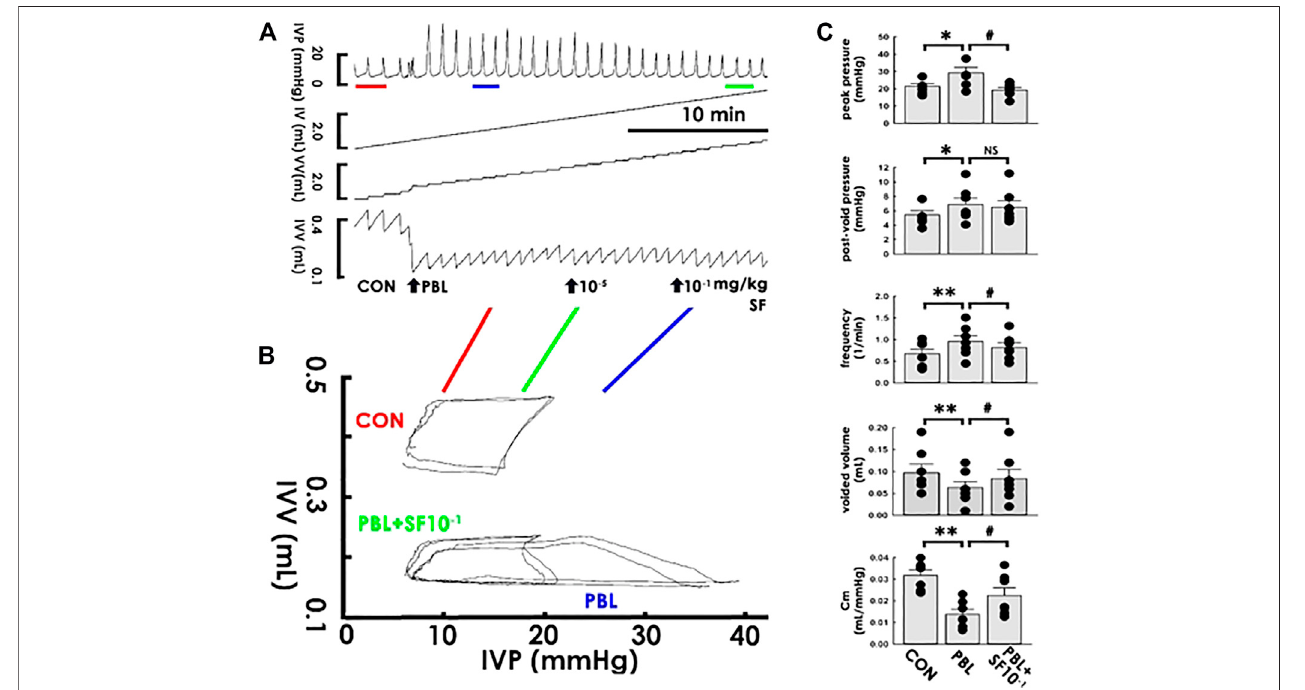
FIGURE 5 | Solifenacin ameliorates bladder ligation-reduced compliance. (A) Cystometry before (control; CON) and in response to a partial bladder ligation (PBL) followed by intra-arterial injections of solifenacin (SF; 10 -5 and 10 − 1 mg/kg, bolus). Red, blue, and green bars at the bottom of IVP mark the cycles displayed in the pressure-volume analysis. (B) Pressure-volume loops showing a partial bladder ligation reduces the slope of the regression line of the fi lling phase that is marked reversed by solifenacin with a concentration of 10 − 1 mg/kg (PBL + SF10 − 1 ). (C) A partial bladder ligation statistically increases the peak pressure, post-void pressure,voiding frequencybutdecreasesvoided volume andmeancompliance(Cm; * p < 0.05,** p < 0.01,vs.CON;all n (cid:2) 7)thatareallameliorated bysolifenacin(1 × 10 − 1 mg/kg; SF1X10 − 1 ) excepting the post-void pressure ( # p < 0.05, vs. PBL; all n (cid:2) 7). IVP, intra-vesical pressure; IV, infused volume; VV, voided volume, IVV intra- vesical